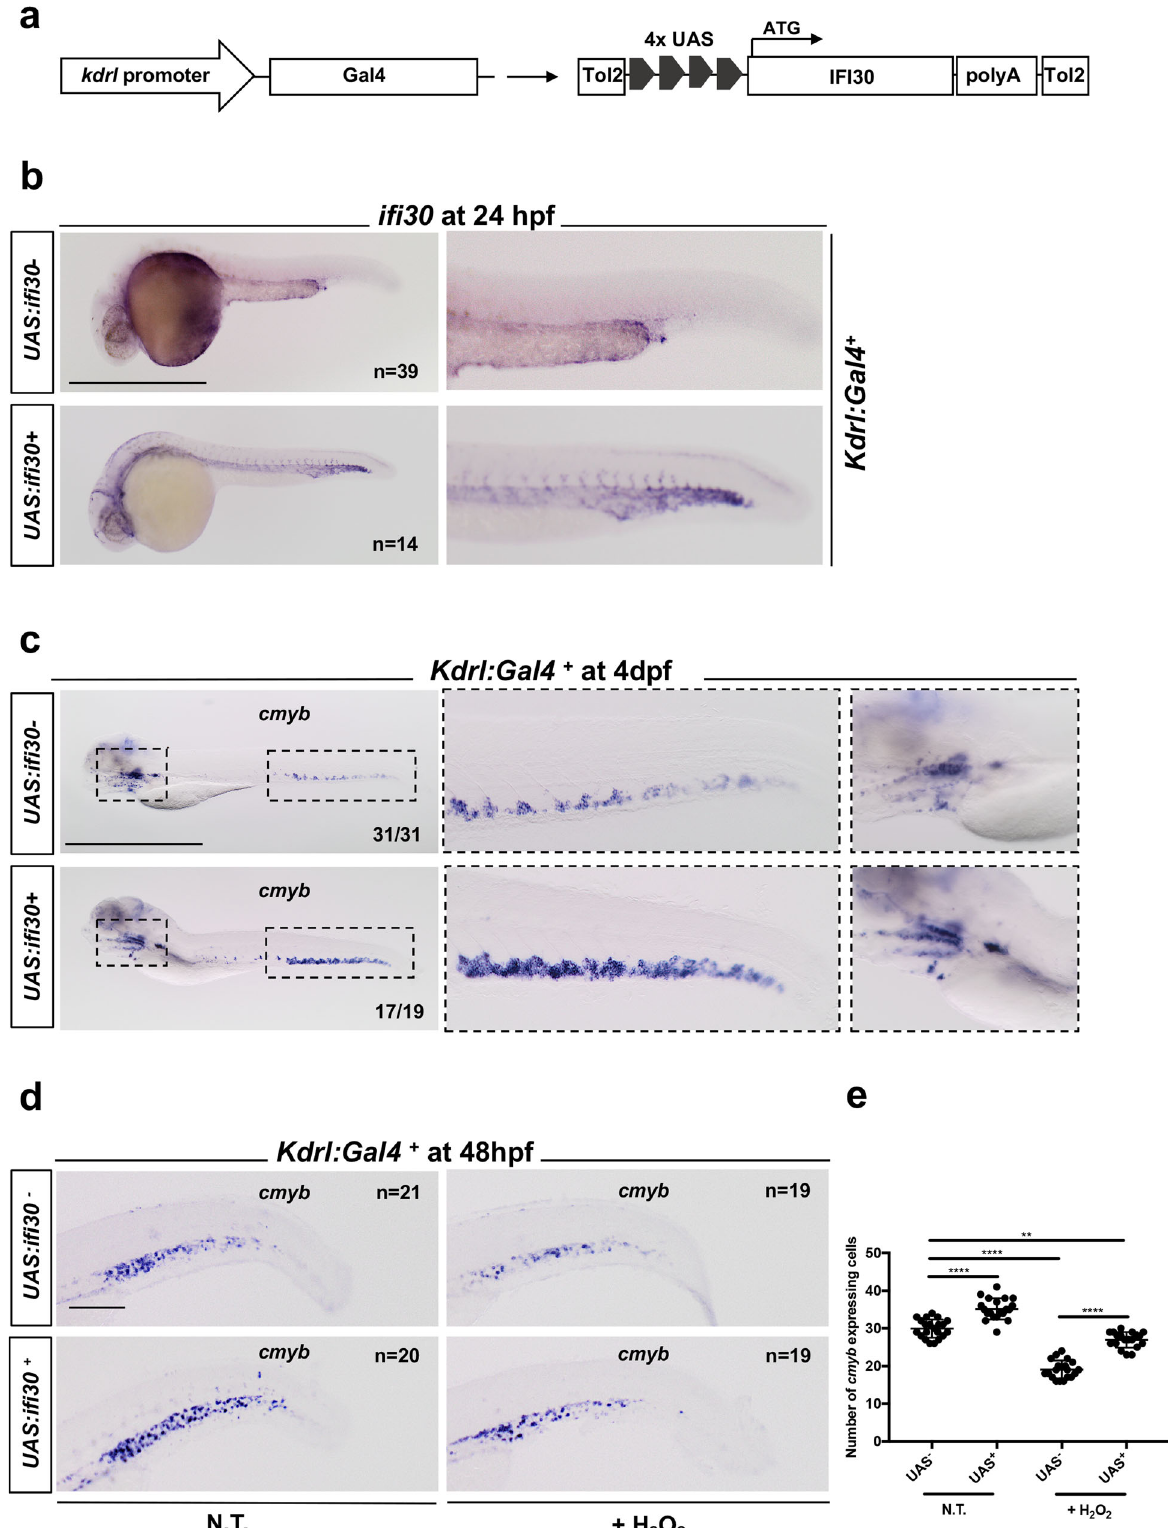
Fig. 3 I fi 30 overexpression increases the number of HSPCs in the CHT and rescues the loss of HSPCs after ROS challenge. a Experimental outline to generate double-transgenic kdrl:Gal4;UAS:i fi 30 . b WISH for i fi 30 at 24 hpf in kdrl:Gal4 + embryos that were either UAS:i fi 30 negative (upper) or positive (lower). c WISH for cmyb at 4 dpf in kdrl:Gal4 + embryos that were either UAS:i fi 30 negative (upper) or positive (lower). d WISH against cmyb at 48 hpf in kdrl:Gal4 + embryos that were either UAS:i fi 30 - (upper) or UAS:i fi 30 + (lower), NT and H 2 O 2 -treated. e Quanti fi cation of cmyb- expressing cells. Statistical analysis: one-way ANOVA with Tukey – Kramer post hoc tests, adjusted for multiple comparisons, ** P = 0.013; **** P < 0.0001. Center values of all statistical analyses denote the mean, and error values denote s.e.m. Scale bars: 200 μ m ( b , c ), 100 μ m ( d